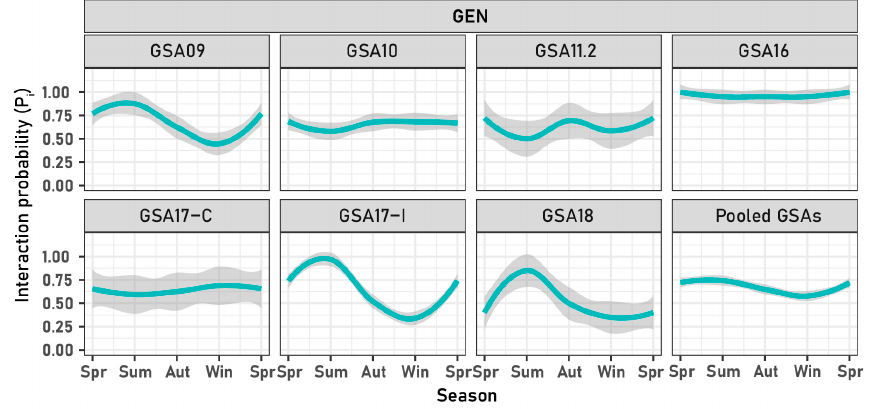
Figure 2. Interaction probability ( P i %) between dolphins and fishing activities throughout the sea- sons in the different Geographical Sub Areas (GSAs) for the set nets (GEN). The cyan line represents the average trend, while the grey shadowed areas represent the 95% confidence intervals.